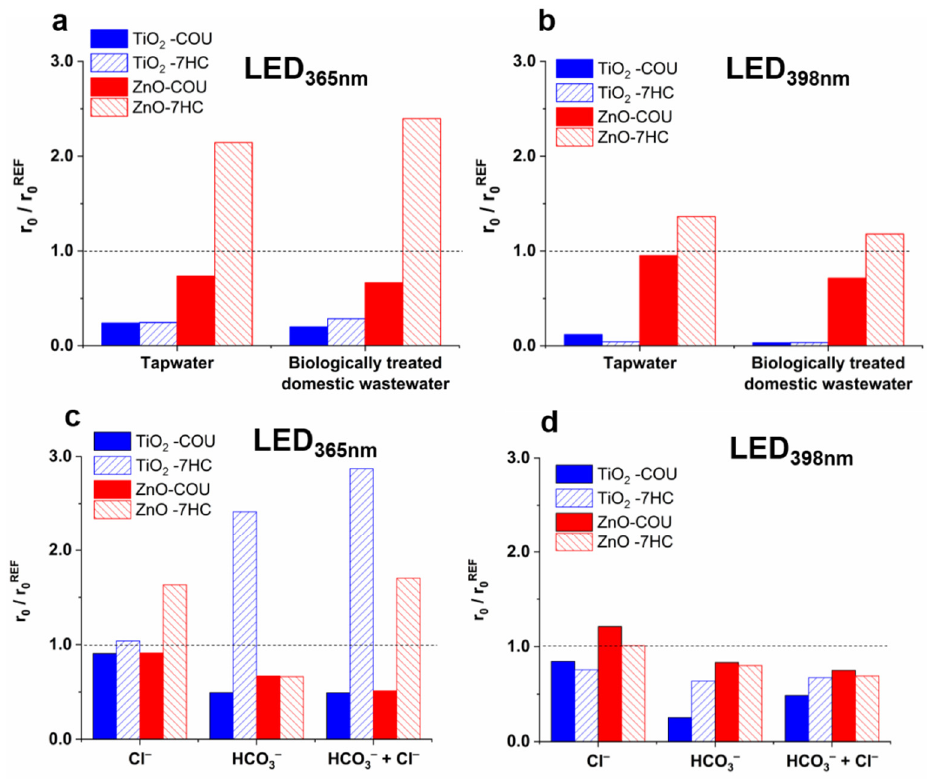
Figure 3. Effect of matrices ( a , b ), Cl − (120 mg dm − 3 ), and HCO 3 − (525 mg dm − 3 ) ( c , d ) on the relative transformation rate of COU and formation rate of 7-HC.